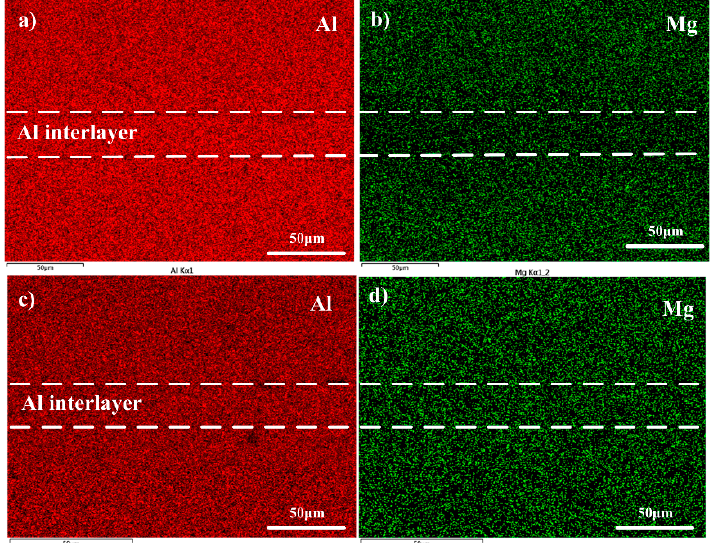
Figure 6. Main alloying element distribution across the bond joint: ( a , b ): 460 °C–6 MPa–60 min; ( c , d ): 520 °C–6 MPa–60 min.